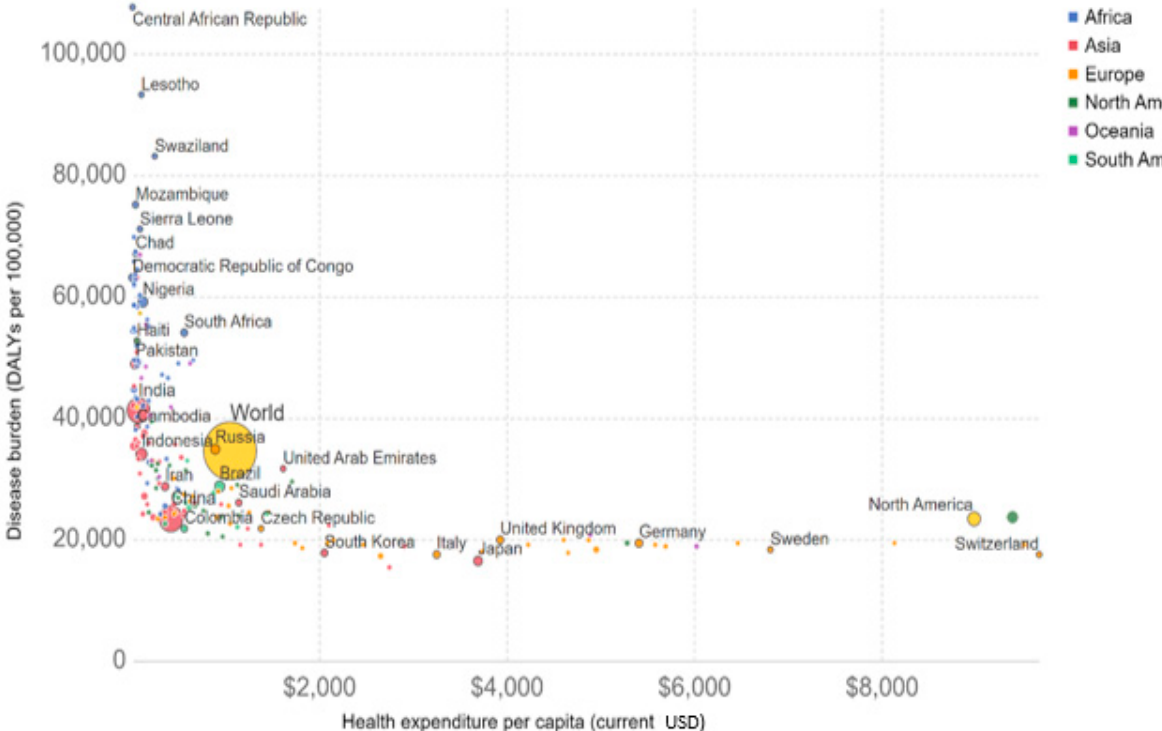
Figure 20. Relationship between gross national income (GNI) per capita vs. DALYs per 100,000 individuals throughout the world in 2012. Information provided by M. Roser and H. Ritchie (2019) in “Causes of Death,” published online at OurWorldInData [87].